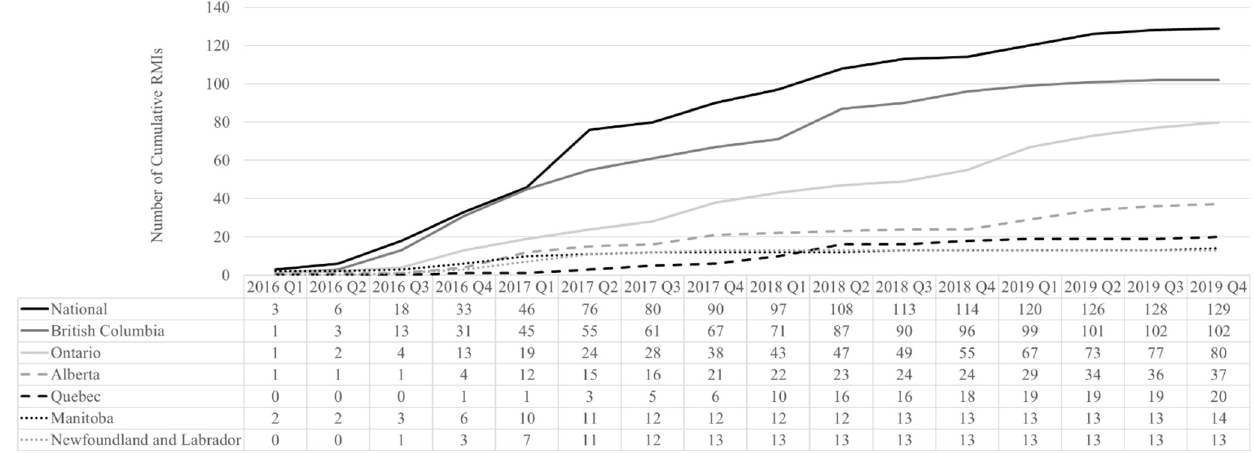
Figure 1. Distribution of opioid interventions and policies in Canada between 2016 and 2019 by year of implementation and province.